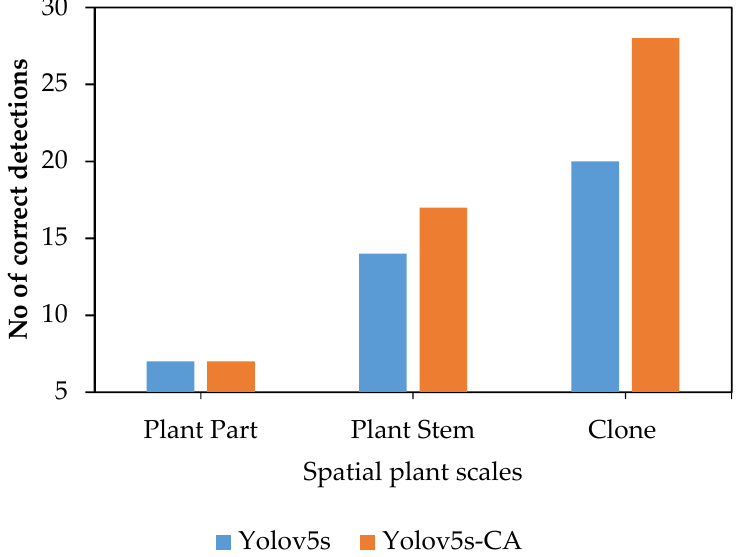
Figure A4. Comparison of correct detection between the Yolov5s and Yolov5s-CA models. Table A1. Number of images in each data subset.